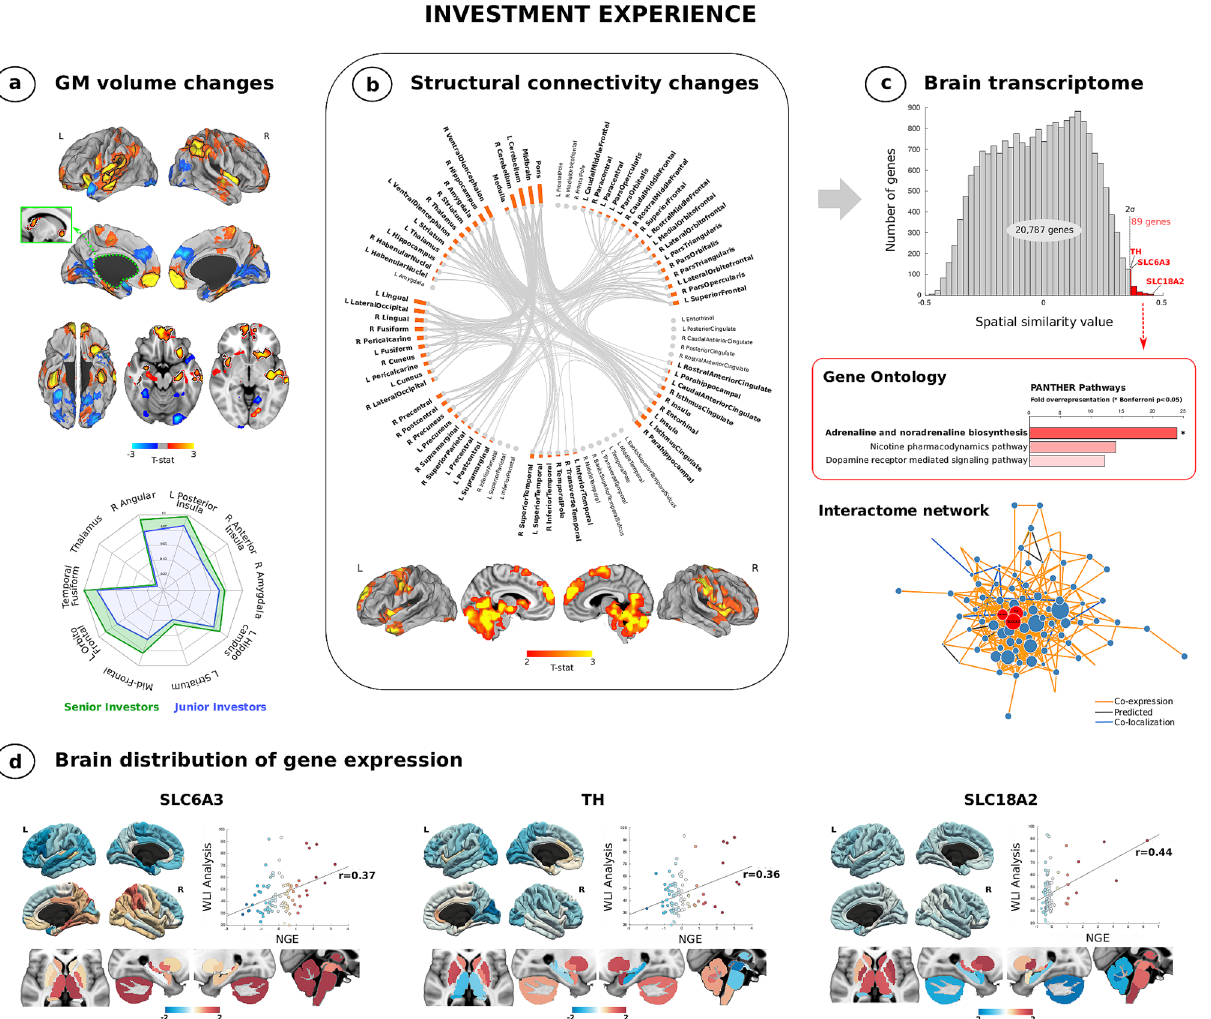
Figure 1. Structural brain changes and cerebral gene expression related to investment experience. ( a ) Cortical and subcortical maps of gray matter volume in senior investors. Red-yellow colors represent higher volume and blue colors lower volume. The results corrected for multiple comparisons are outlined in black ( Top ). Radar plot is shown ( Bottom ). ( b ) Connectogram of structural connectivity and brain projections of the weighted- degree of link-level interaction analysis related investment work experience. ( c ) Genes whose similar spatial distribution correlated with brain connectivity maps shown in b ( top ). Genetic pathways associated with these 89 genes ( middle ). Genetic functional network exhibiting the centrality of SLC6A3, TH and SLC18A2 ( bottom ). ( d ) Projections of cortical and subcortical areas of the distribution of these genes in the brain. SLC6A3 (p = 0.00029557), TH (p = 0.00043982) and SLC18A2 (p = 0.00001728). WLI analysis weighted-degree of link- level interaction analysis, NGE normalized gene expression, R right, L